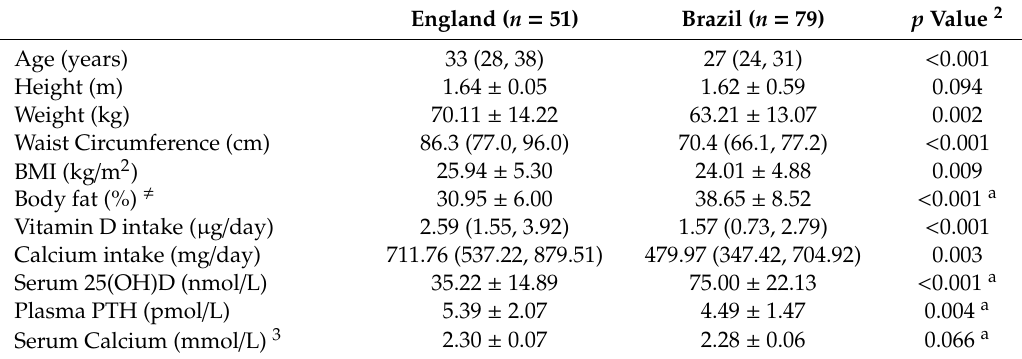
Table 1. Characteristics of adult Brazilian women by country of residence ( n = 130) 1 .